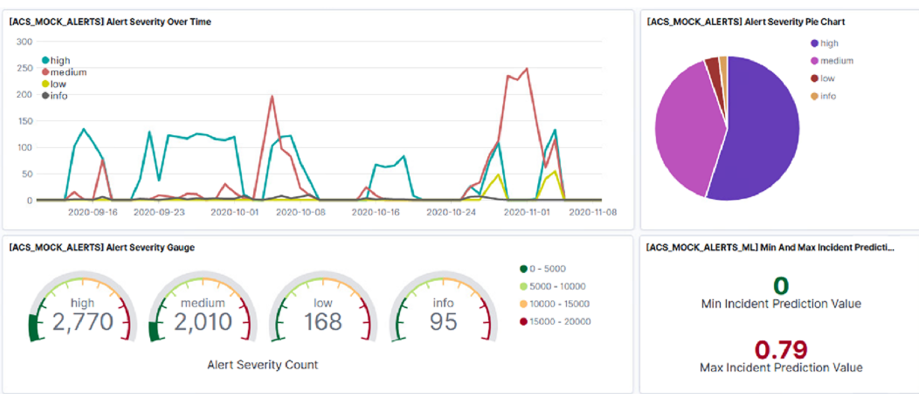
Figure 10. Alerts Dashboard—Alert severity monitoring